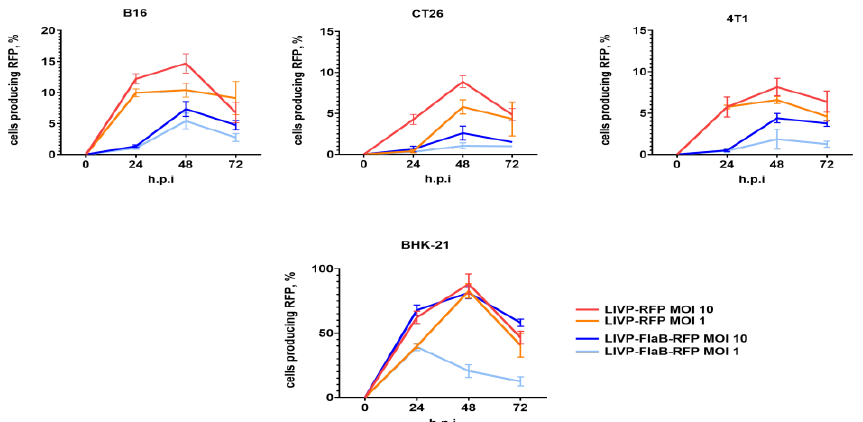
Figure 3. Viral kinetics . Flow cytometry assessment of virus replication kinetics at 24, 48, and 72 h post-infection (h.p.i) in the different cell cultures of BHK-21, B16, CT26, and 4T1 with recombinant virus variants.